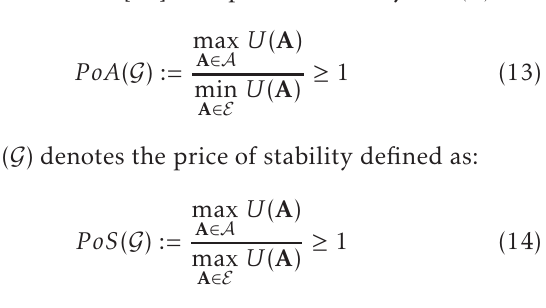
Figure 2. In graphical games how users learn is as much important as who learns